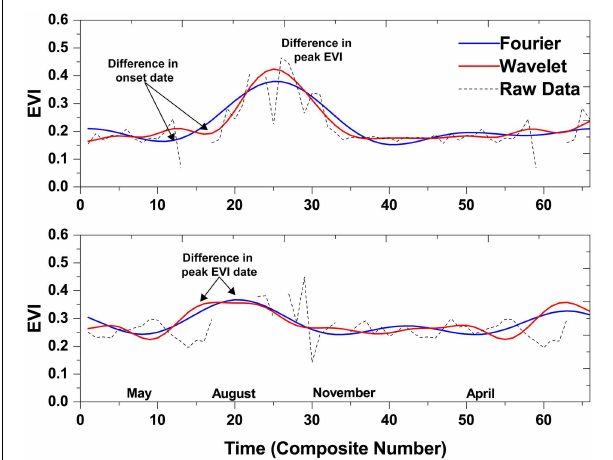
FIGURE 2 | Smoothed phenology profiles, using Fourier and wavelet transforms, for the same pixels in Figure 1 (i.e., agricultural pixels in Odisha, Eastern India for the 2008–2009 cropping season. Annotations demonstrate how different smoothing techniques yield different start-of-season and peak VI retrievals. The time-series here has been extended to capture a potential second cropping season after the monsoon; the cropping season time-series displayed spans mid-March (pre-monsoon) in 2008 to the mid-May in 2009 (end of harvest of the post-monsoon